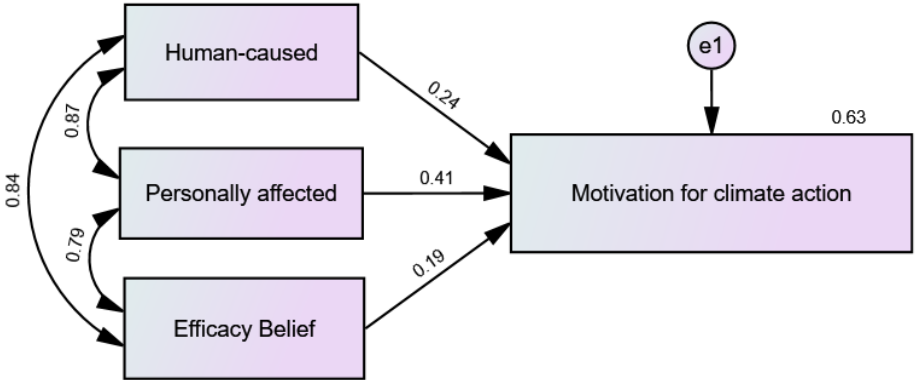
Figure 4. Impacts of Post-intervention Climate Action Precursors on Post-intervention Climate Action Motivation.